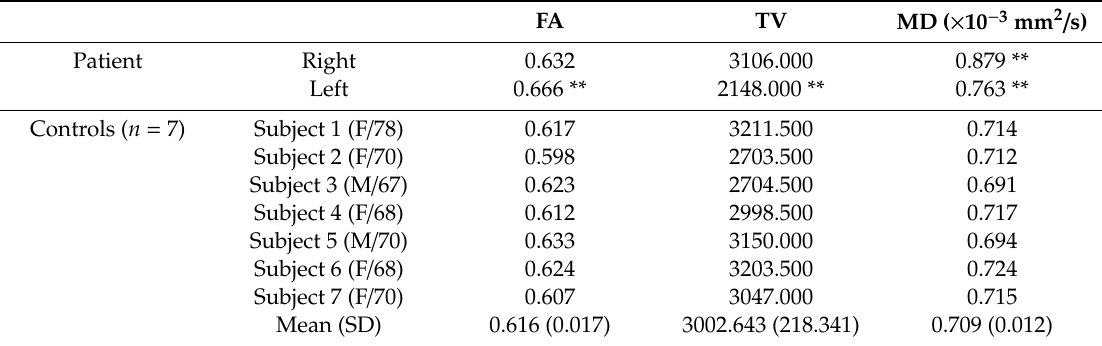
Table 1. Di ff usion tensor tractography (DTT) parameter values of the corticospinal tracts of the patient and control